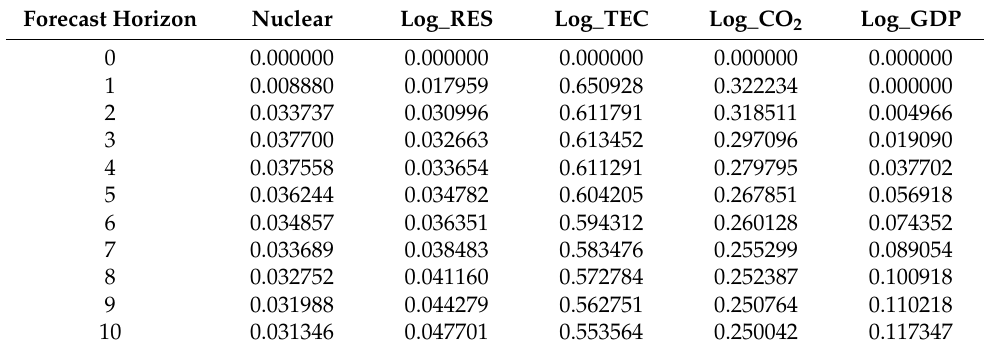
Table 8. Forecast error in response variable Log_CO 2 .